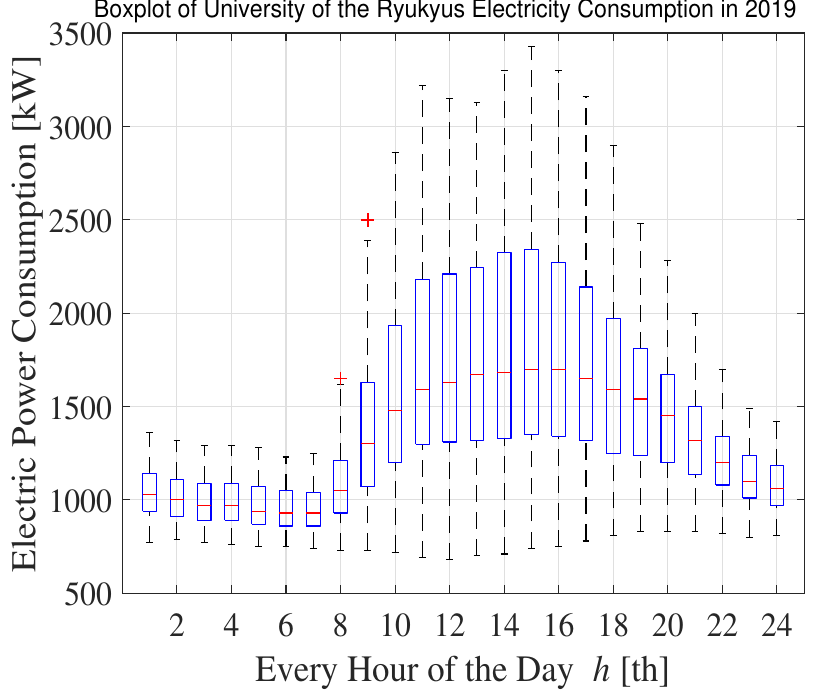
Figure 4. Electricity consumption of the University of the Ryukyus in